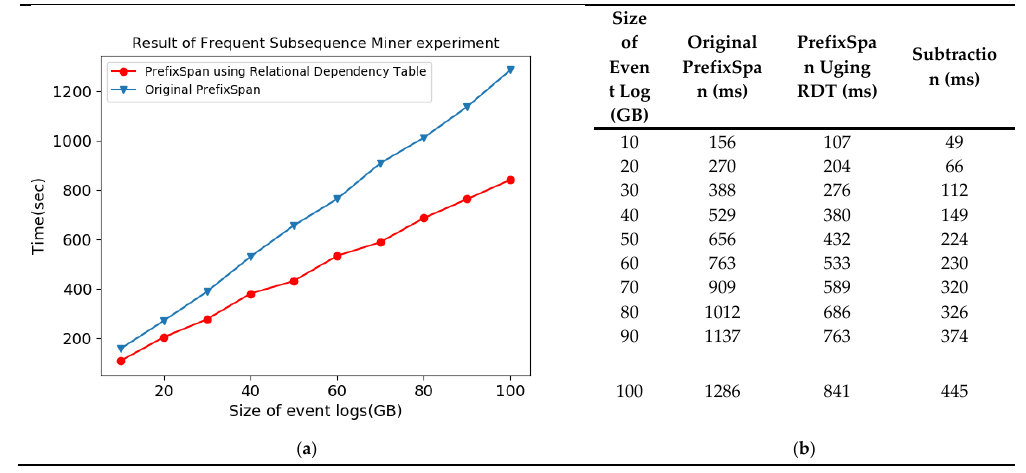
Figure 15. Result of Frequent Subsequence Miner experiment. ( a ) Result of frequent subsequence miner test; ( b ) Details of test result.